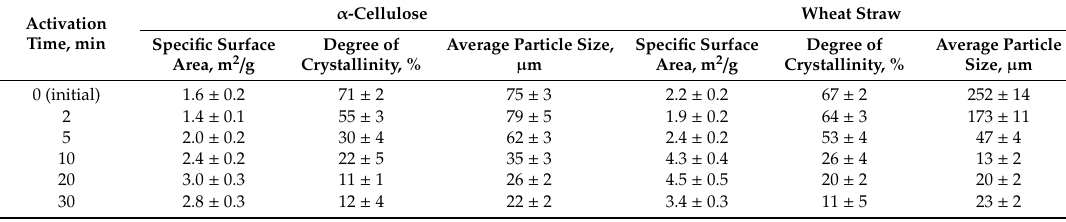
Table 1. Changes in the specific surface area, degree of crystallinity and particle size of α -cellulose and wheat straw.